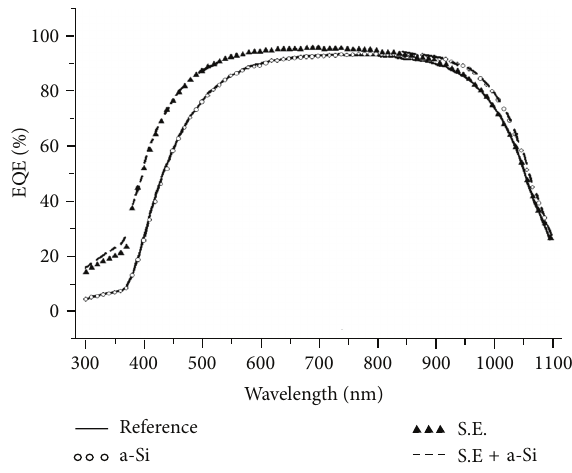
Figure 7: External quantum efficiency (EQE) versus optical wave- length for a reference cell (—), a back surface a-Si:H deposited cell ( ∘ ∘ ∘ ), a selective emitter cell ( 󳵳󳵳󳵳 ) and a back surface a-Si:H deposited selective emitter cell (- - -).